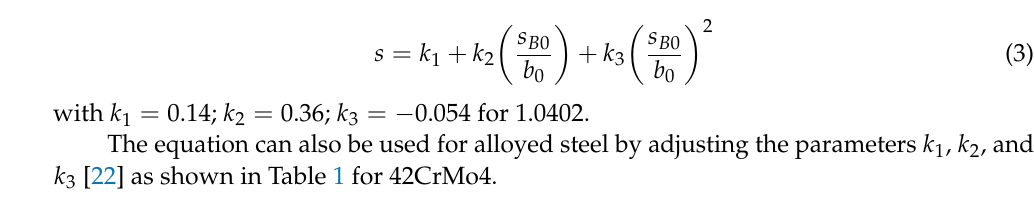
Table 1. Tomlinson and Stringer parameters for 42CrMo4 [23].